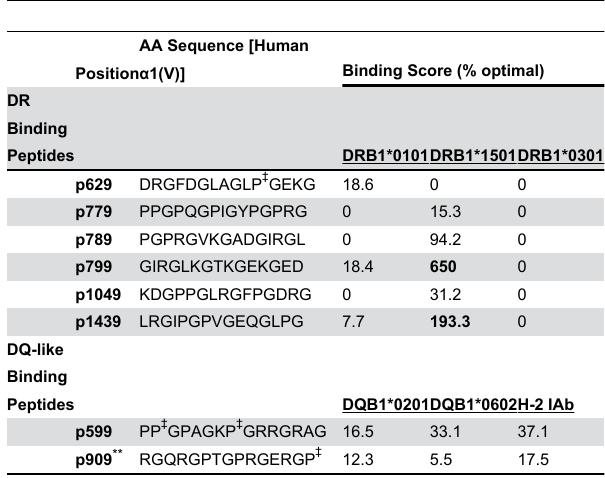
Table 2. Pan-Allele ProImmune REVEAL binding assay data for